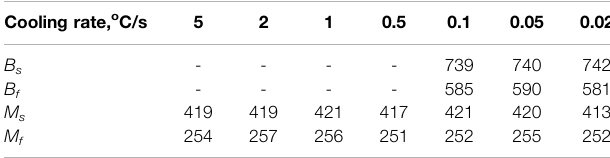
TABLE 6 | The phase transformation temperatures during different cooling